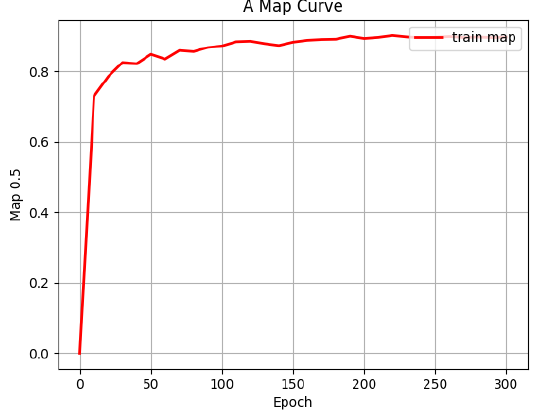
Figure 13. Training loss curve of VV-YOLO model.